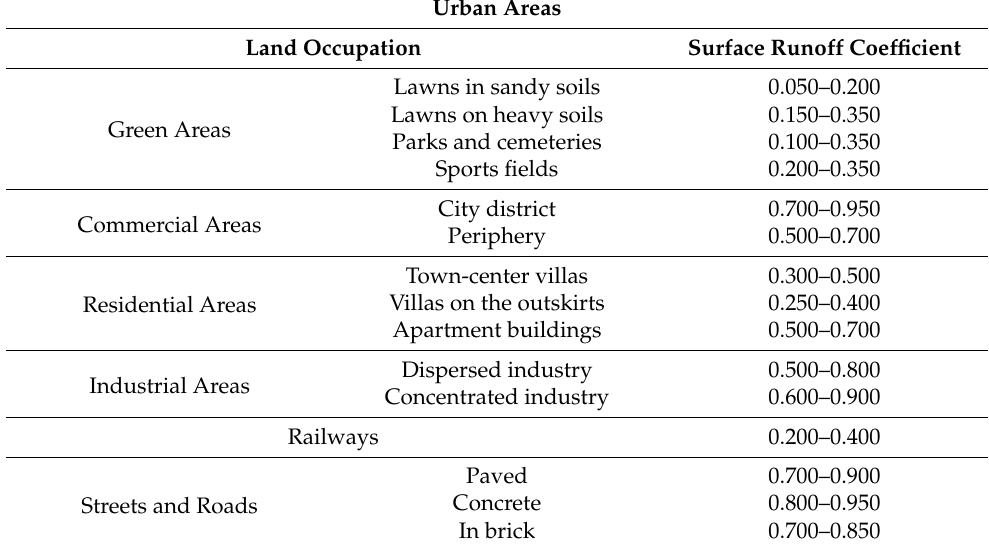
Table A2. Surface runoff coefficients (Source: [25]).